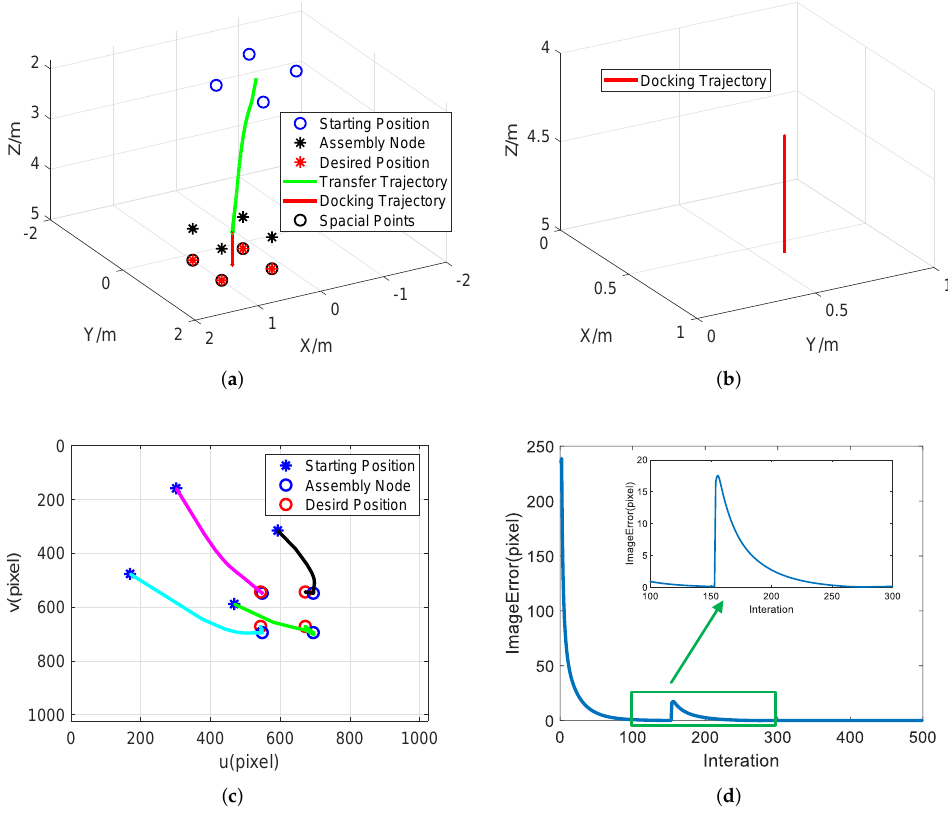
Figure 6. The First Simulation Result by The Proposed Method: ( a ) Complete Spatial trajectory of the robotic arm. ( b ) Docking trajectory. ( c ) Image trajectory. ( d ) Position error in the image.